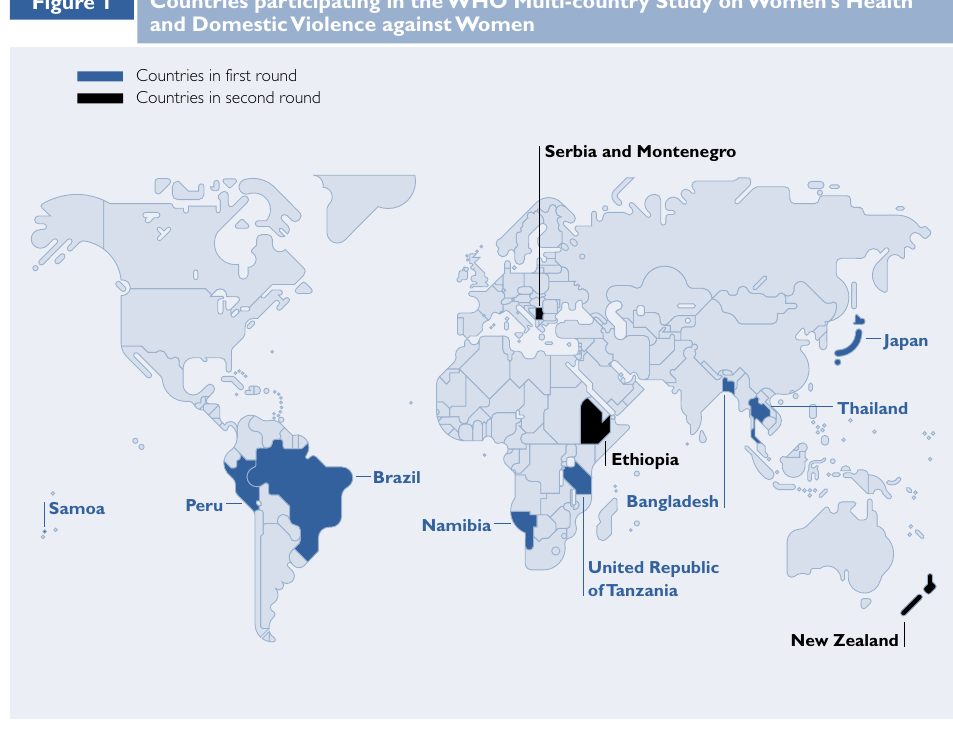
Figure 1 Countries participating in the WHO Multi-country Study on Women’s Health and Domestic Violence against Women Countries in first round Countries in second